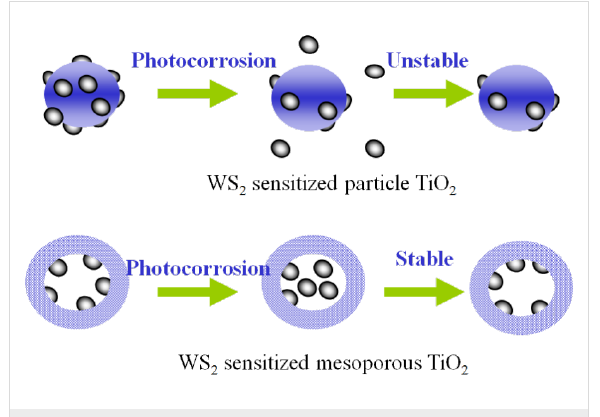
Figure 2: Illustration of mesoporous wall on the anti-photocorrosion of sulfide photocatalyst.